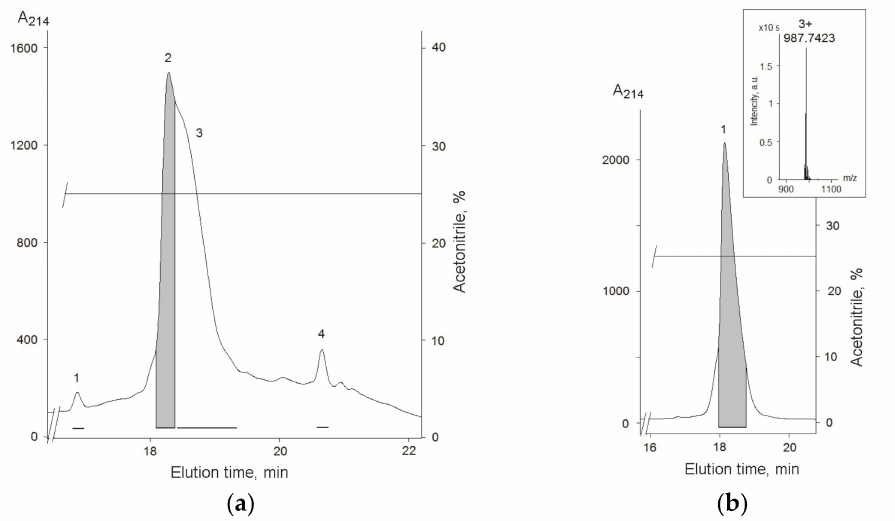
Figure 2. ( a ) RP-HPLC of fraction 3, obtained after the first step RP-HPLC, on a C18-PFP (10 mm × 250 mm) column in a gradient of acetonitrile with 0.1% TFA. ( b ) Purity check on RP-HPLC C18-PFP (10 mm × 250 mm) column. ESI MS measure of average molecular weight of peptide is shown in insert. Fractions from which the peptide was isolated are gray